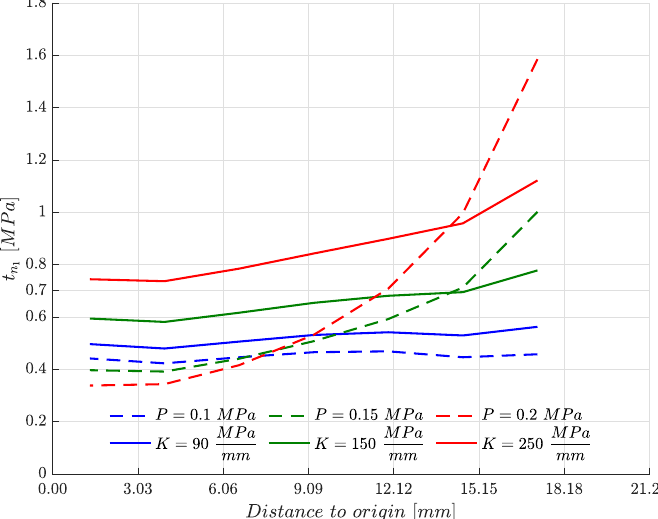
Figure 9. Normal contact traction distribution comparsion at the nodes located at the diagonal of the contact zone for the uniform clamping pressure and Winkler elastic supports.